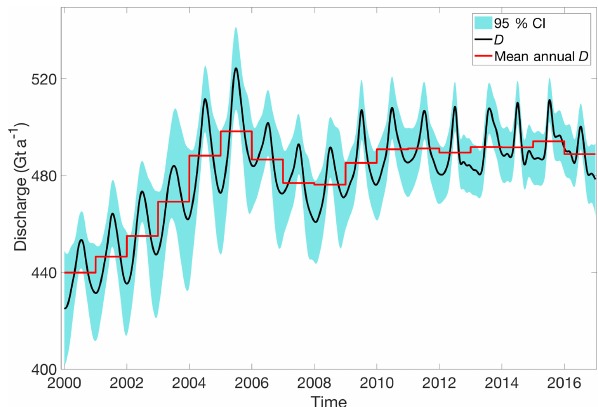
Figure 1. Continuous estimates of discharge, D , for the GrIS for the 2000–2016 period, expressed as the rate of gigatonnes per year (Gta − 1 ). Shading represents the 95% confidence